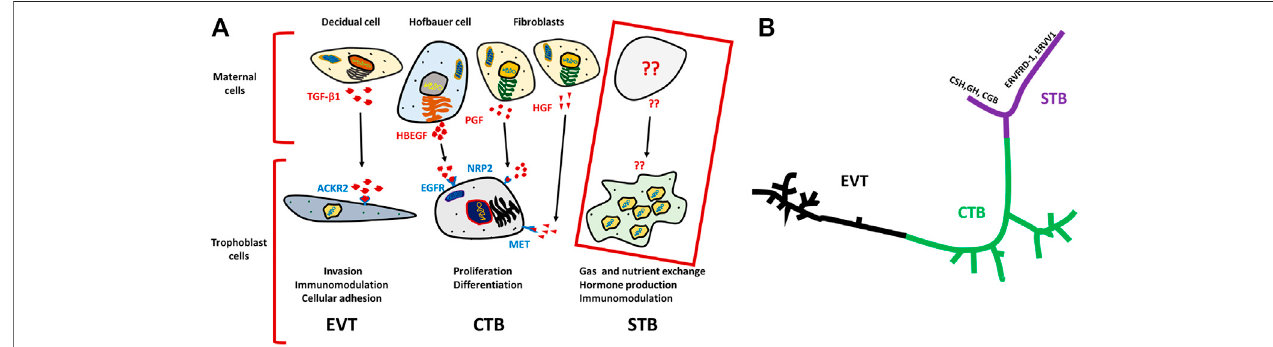
FIGURE1| Schematicsforligand – receptorpairsandPseudotimeanalysisofTBcells. (A) Ligands(indicatedinred)arereleasedbyvariousmaternalcells,ofwhich predicted receptors are present on respectiveTB cells(indicated inpurple). TGF- β 1ligandsfor ACKR2ofEVT cells, isreleased bydecidualcells and predicted totrigger EVT invasion, immunomodulation and cellular adhesion. Similarly, EGFR present on CTB potentially interacts with HBEGF released by Hofbauer cell, and PGF and HGF ligands are secreted from fi broblast cells for which predicted receptors NRP2, and MET are present on CTB. Together, they trigger proliferation and differentiation ofCTB.Incontrast,suchinteractionswerenotdeterminedforSTBsDevelopedonthebasisofanalysisfromVento-Tormoetal.(Vento-Tormoetal.,2018). (B) U-shaped trajectory from pseudo time analysis, where CTB is present at center while, EVT and STB are present at the opposite ends. STBs are further bifurcated one arm has upregulated hormone genes (CSH, GH, CGB) and the other arm showed upregulation of fusogens (ERVFRD-1, ERVW-1 ERVV1) Reproduced with permission from Tsang et al. (Tsang et al., 2017). TB, trophoblast; EVT, extra villous trophoblast cells; CTB, cytotrophoblast cells; STB, syncytiotrophoblast.